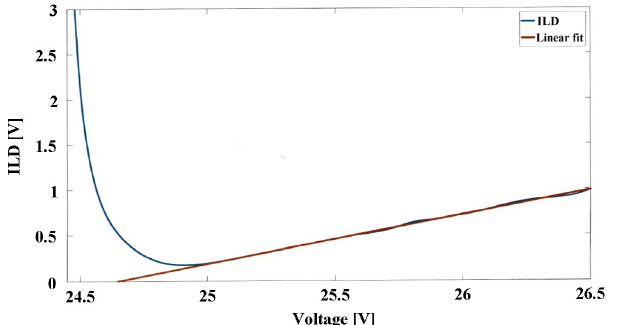
Fig. 2. ILD curve and the linear fit intersect with the voltage axis to yield the breakdown voltage.